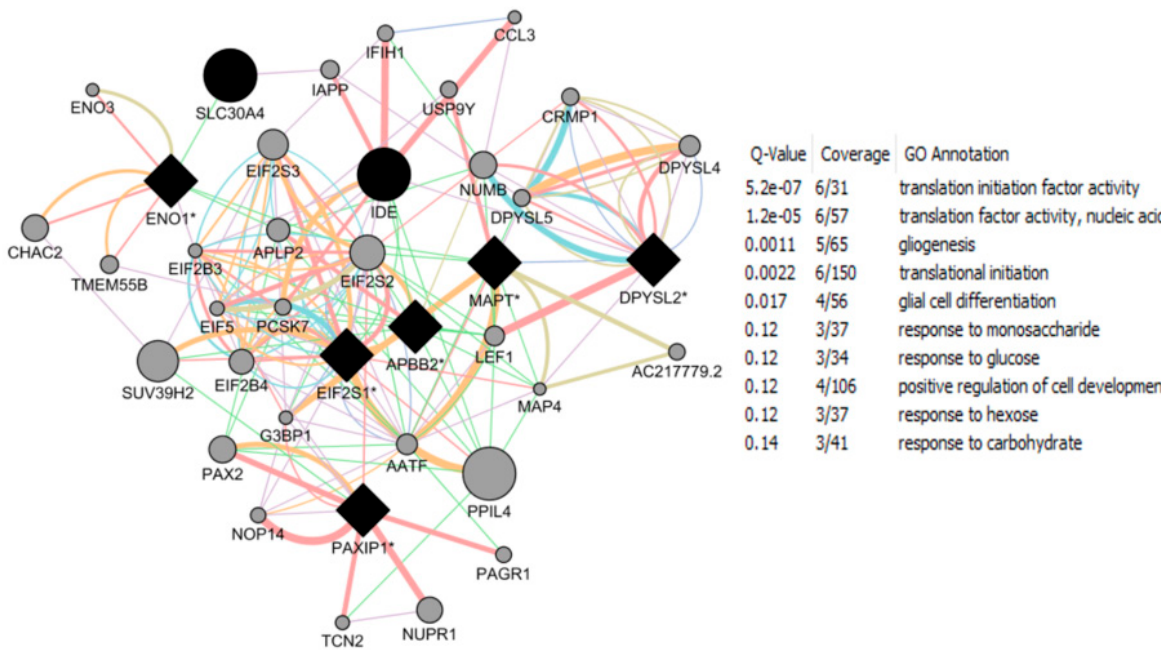
Figure 6. Gene set pathway enrichment analysis of bisphenol-A (BPA) responsive R2 and NRF1common target genes associated with Alzheimer’s Disease (AD). The network includes the top 30 BPA-related genes in AD in gray. Bisphenol-A responsive NRF1 genes are in black. Genes denoted by a diamond-shaped node and * are E2 and NRF1 responsive. Right panel show GO annotations of E2 and NRF1 enrichment network genes of BPA associated with biological process pathways involving multiple E2 and NRF1 genes and Q -value as a probability showing number of genes out of the total genes annotated to each GO term.